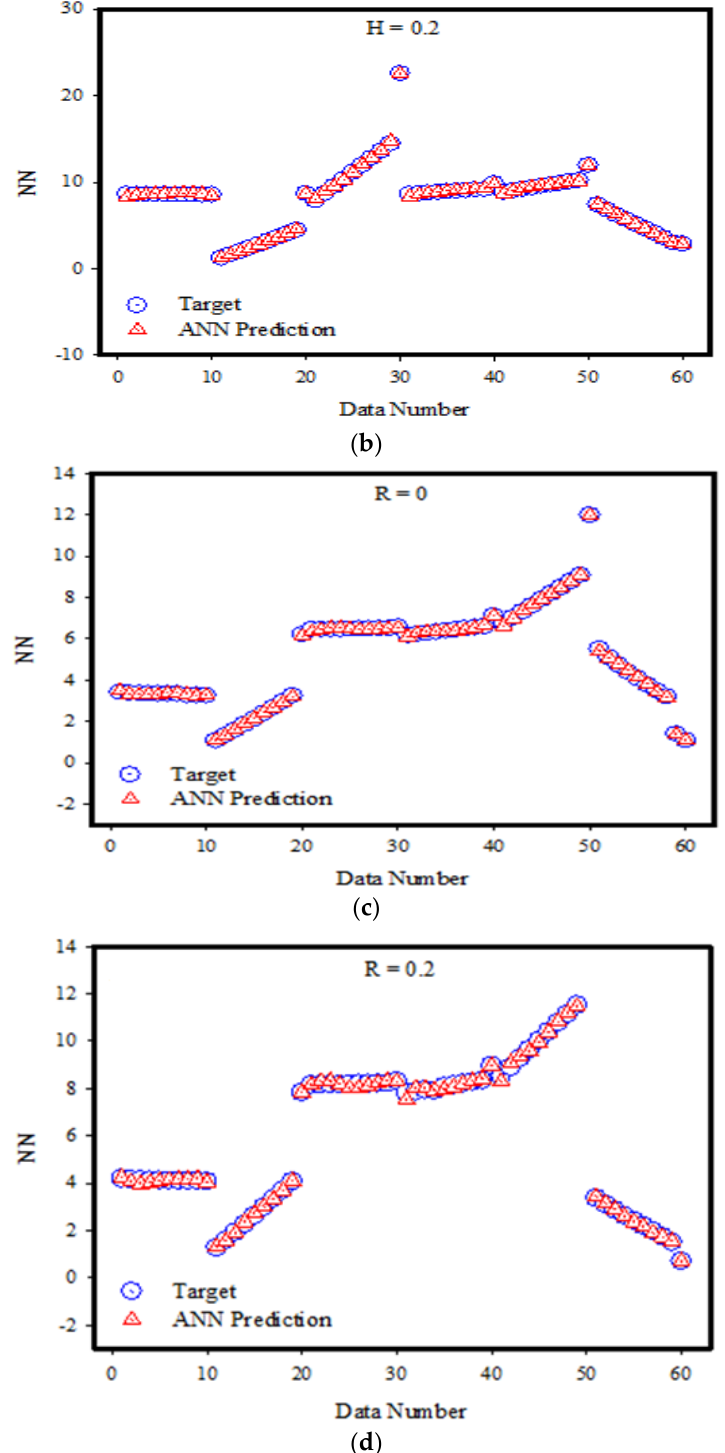
Figure 5. ( a ) The predicted and target values according to data number without heat generation effect. ( b ) The predicted and target values according to data number with heat generation effect. ( c ) The predicted and target values according to data number without radiation effect. ( d ) The predicted and target values according to data number with radiation effect.